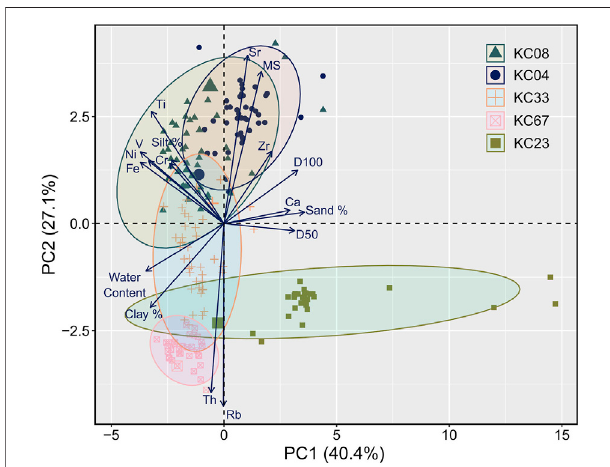
FIGURE 7 | Biplot projecting results of PCA. Variance in principal component (PC) one is largely controlled by grain-size parameters and water contentwhilePC2varianceisin fl uencedbytraceelementconcentrations.The surface sample (0 – 2 cm) for each core is indicated by an enlarged symbol, and concentration ellipses are drawn to include the 95th